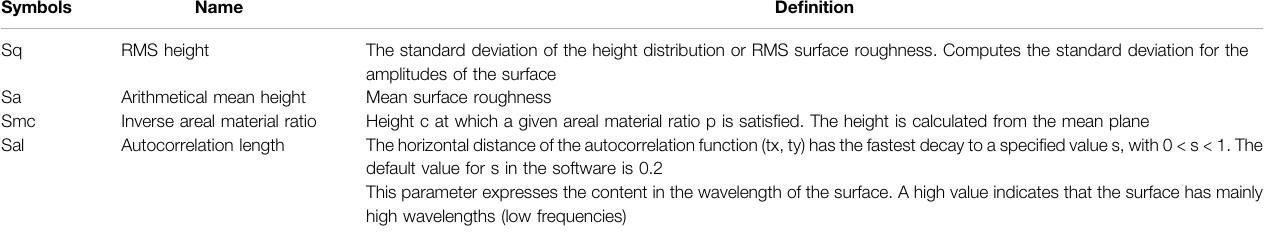
TABLE 2 | De fi nitions of three-dimensional morphological parameters.